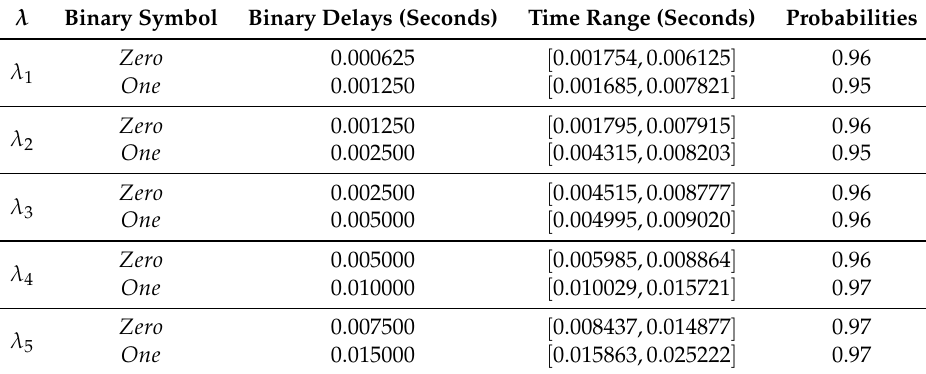
Table 5. Time ranges of binary covert traffic in network configuration